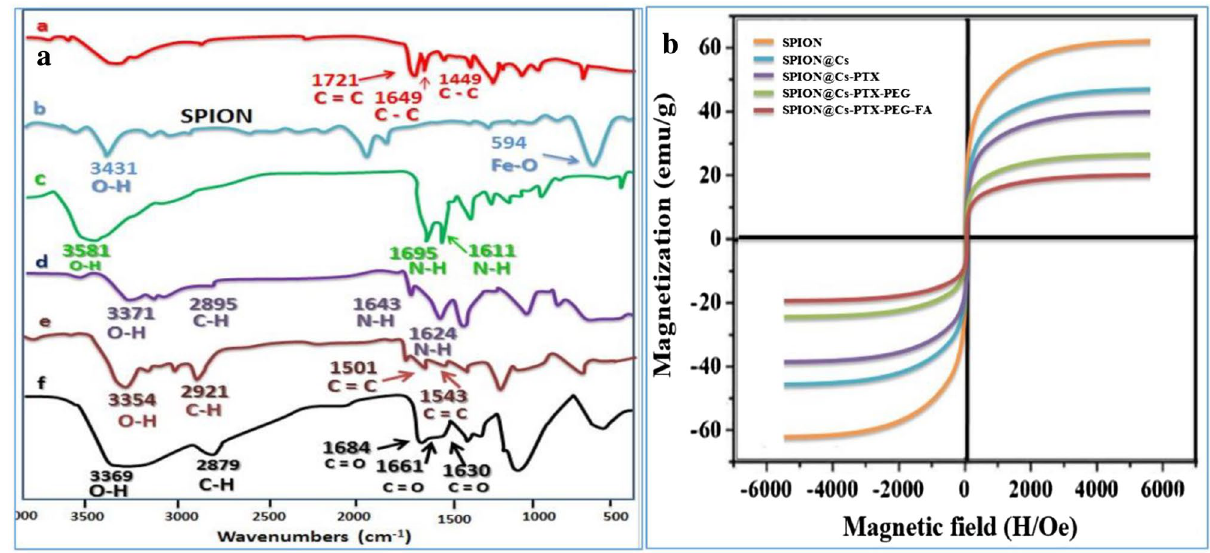
Figure 12. ( a ) FTIR spectra of PTX (a), SPION (b), FA (c), SPION@Cs (d), SPION@Cs-PTX-PEG (e), and SPION@Cs-PTX-PEG-FA (f). ( b ) VSM of different formulations of SPION.